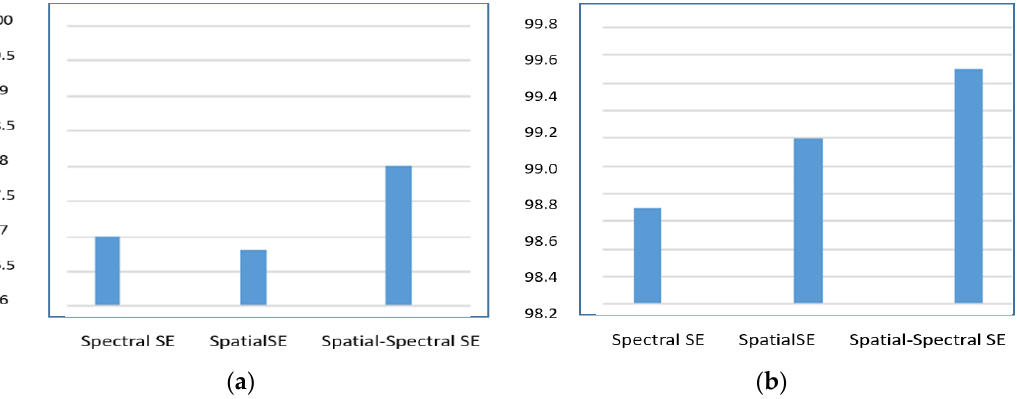
Figure 12. The trainable coefficient 𝜃 vs. overall accuracy (OA%): ( a ) 5% training samples; ( b ) 10% training samples.